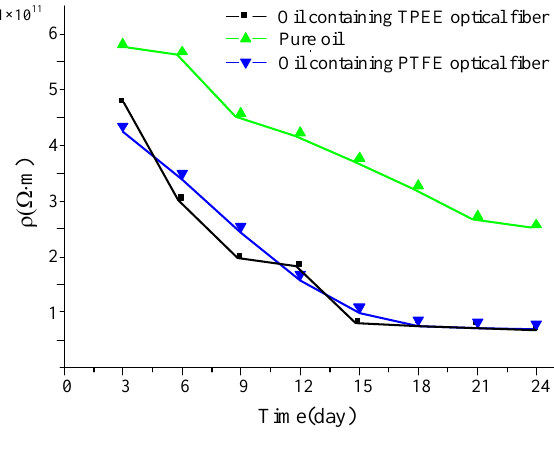
Figure 2. Volume resistivity of oil.